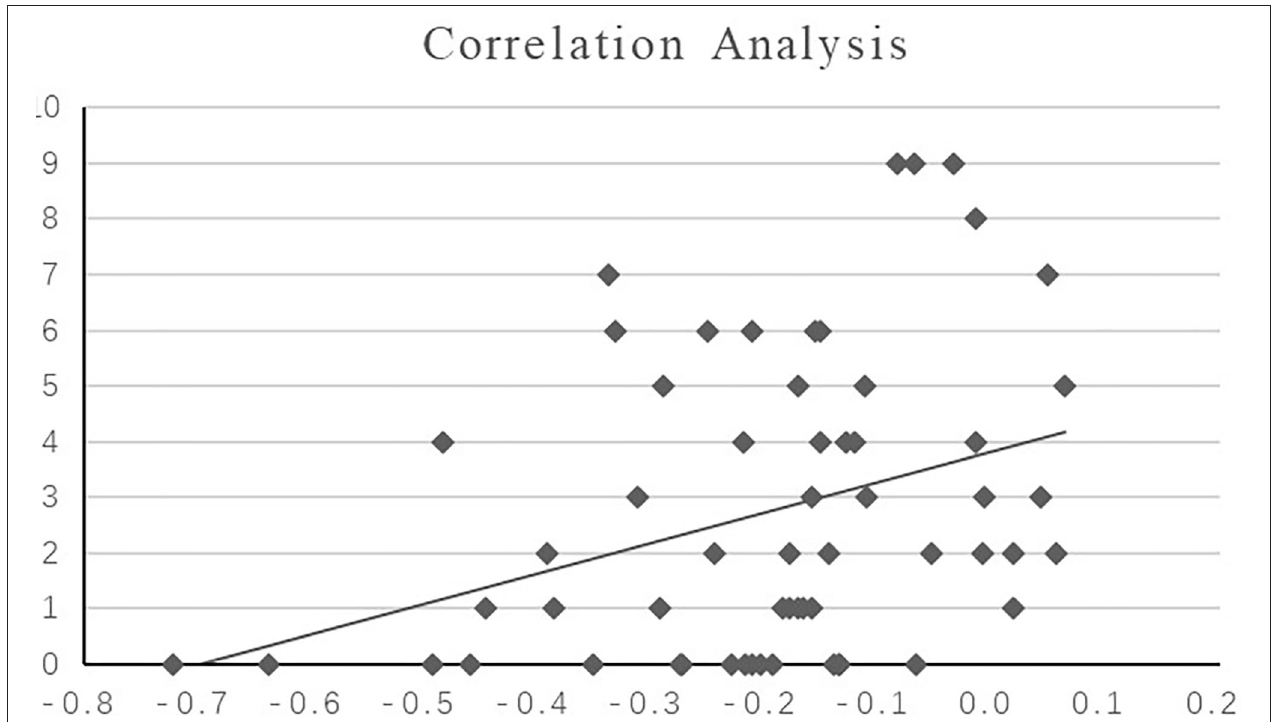
FIGURE 3 | Correlation analysis between the HAMD core depression score and hippocampal-medial frontal lobe rs-FC value in FE-SZ. X-axis: the value of significant region (bilateral medial superior frontal gyrus); Y-axis: core depression